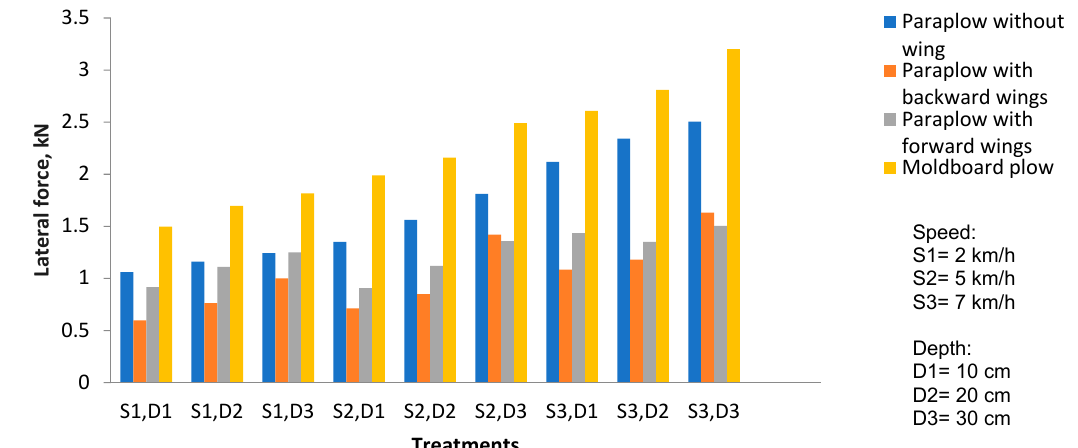
Figure 6. Mean lateral forces under different implements and treatments, S and D show speed and depth, respectively.